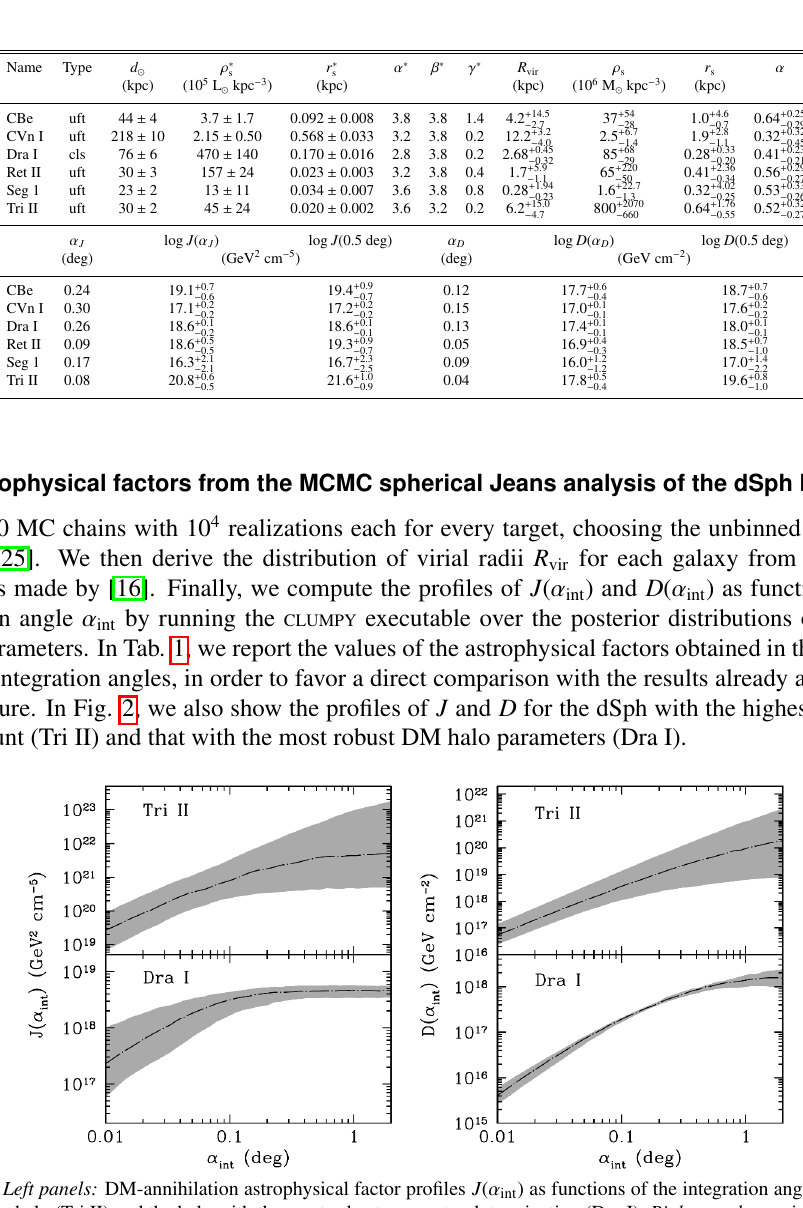
int ) as functions of the integration angle α int for the